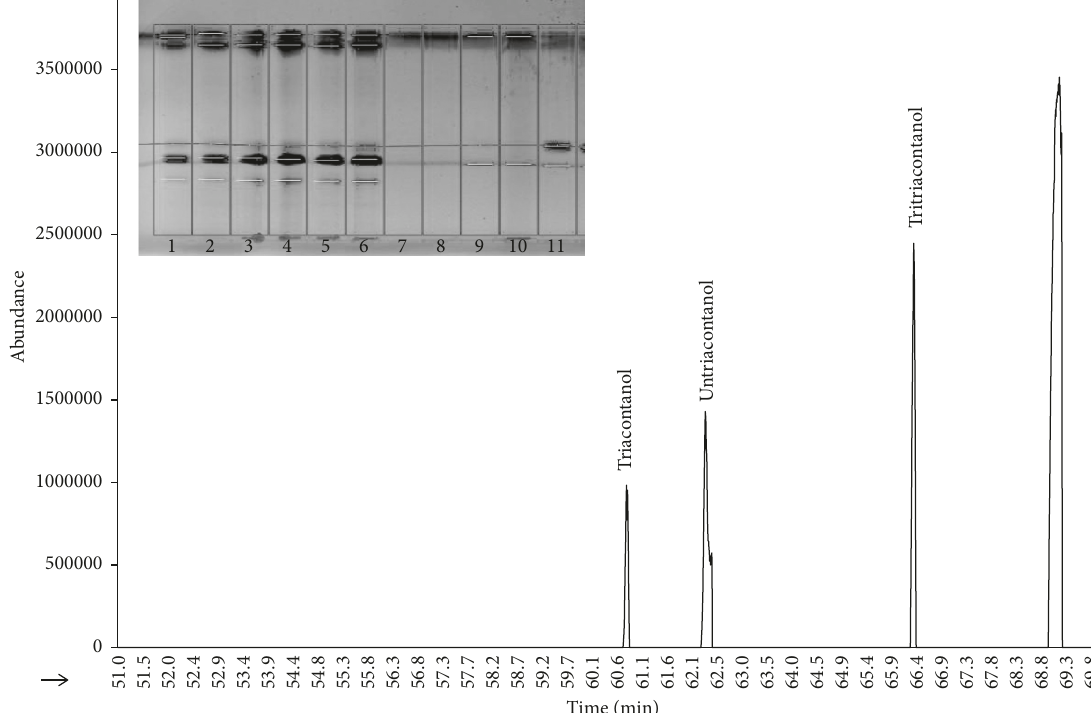
Figure 4: Policosanol composition using isopropanol as acyl receptor in toluene medium from enzymatic transesterification assisted by sonication. HPTLC chromatoplate shows products of the reaction over time from lane 1 to 6; lanes 7 and 8 are the reaction target without enzyme; lanes 9 and 10 are the purified wax; and lane 11 is the triacontanol standard